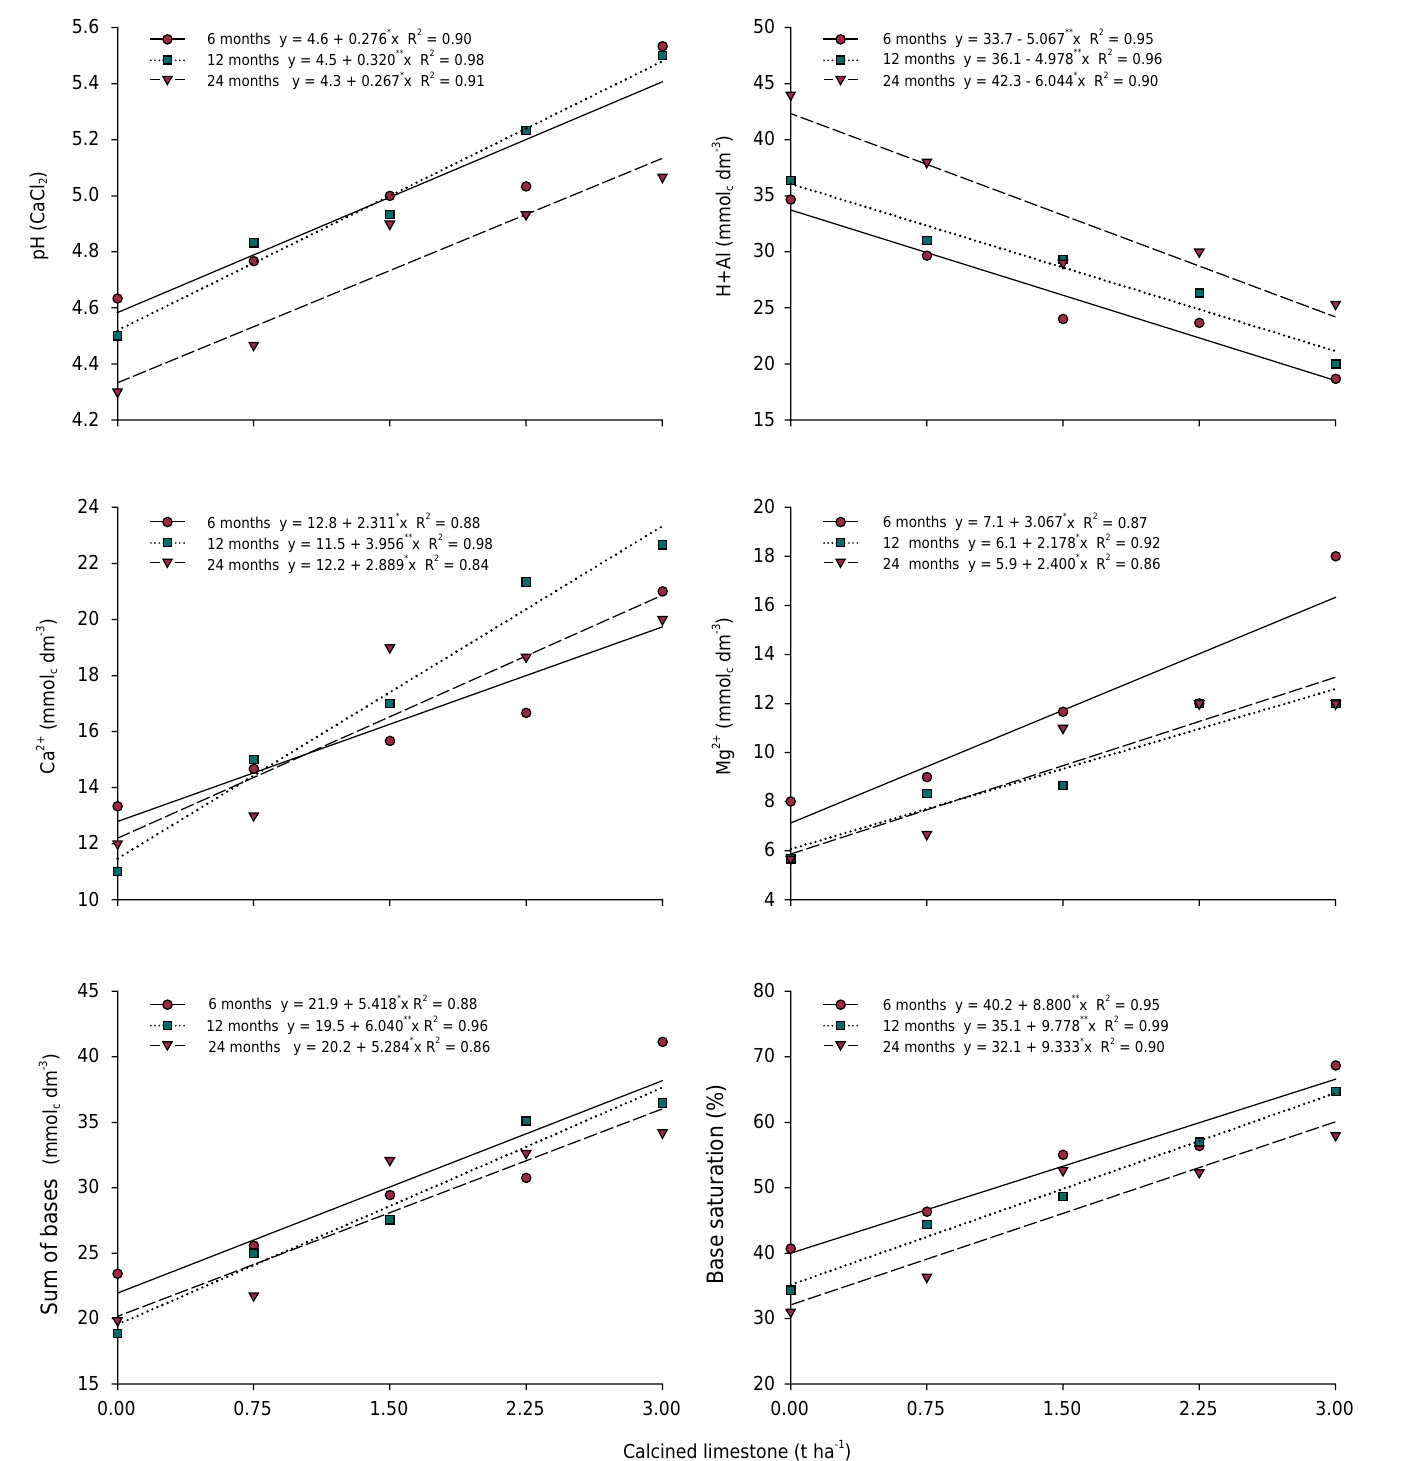
Figure 2. The pH value, potential acidity Ca 2+ , Mg 2+ , sum of bases, and base saturation in the 0.00-0.10 m layer of an Argissolo Vermelho Amarelo [Ultisols (Soil Survey Staff, 2014)] in response to the rates of calcined limestone applied, without incorporation. The dots represent the averages of three replicates. ** and * indicate significance at 1 and 5 % probability,